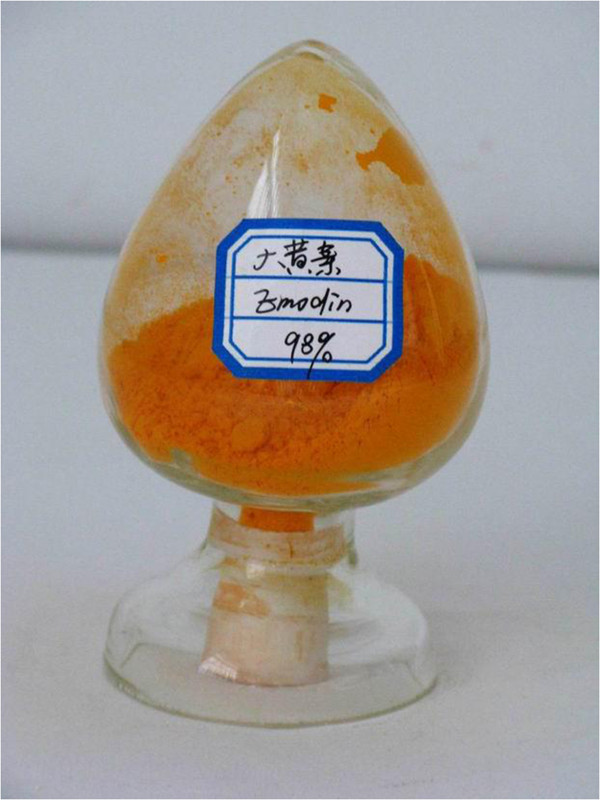
The picture of the traditional chinese herb emodin ingredient.